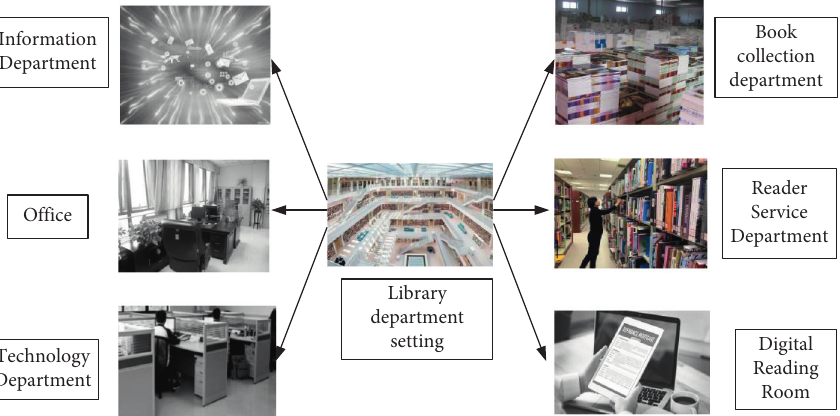
Figure 2: Library organization